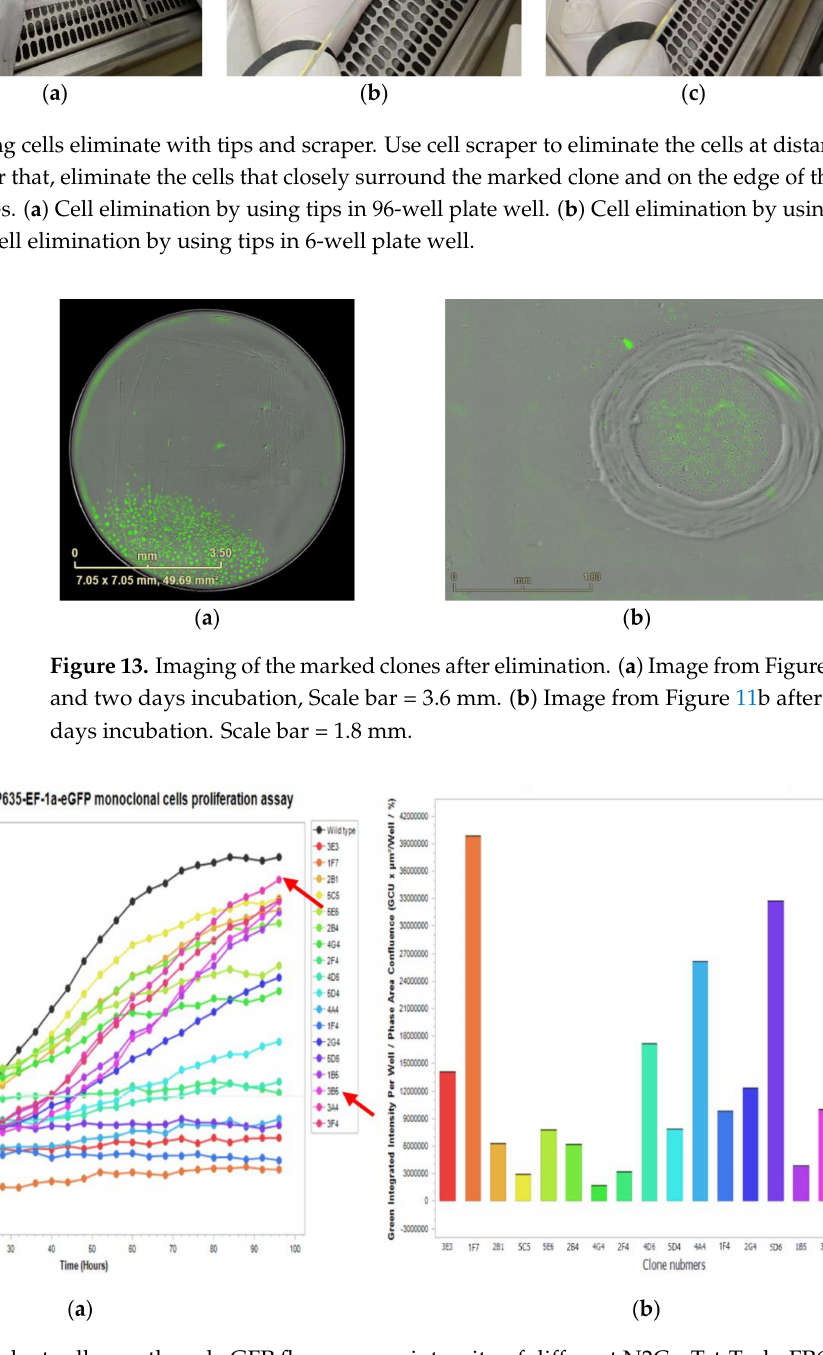
Figure 14. Time-dependent cell growth and eGFP fluorescence intensity of different N2C-pTet-TurboFP635-EF-1a-eGFP monoclonal cells. ( a ) Time-dependent cell growth of different N2C-pTet-TurboFP635-EF-1a-eGFP monoclonal cells. The clone 3A4 is marked by red arrow. ( b ) eGFP fluorescence intensity of different N2C-pTet-TurboFP635-EF-1a-eGFP monoclonal